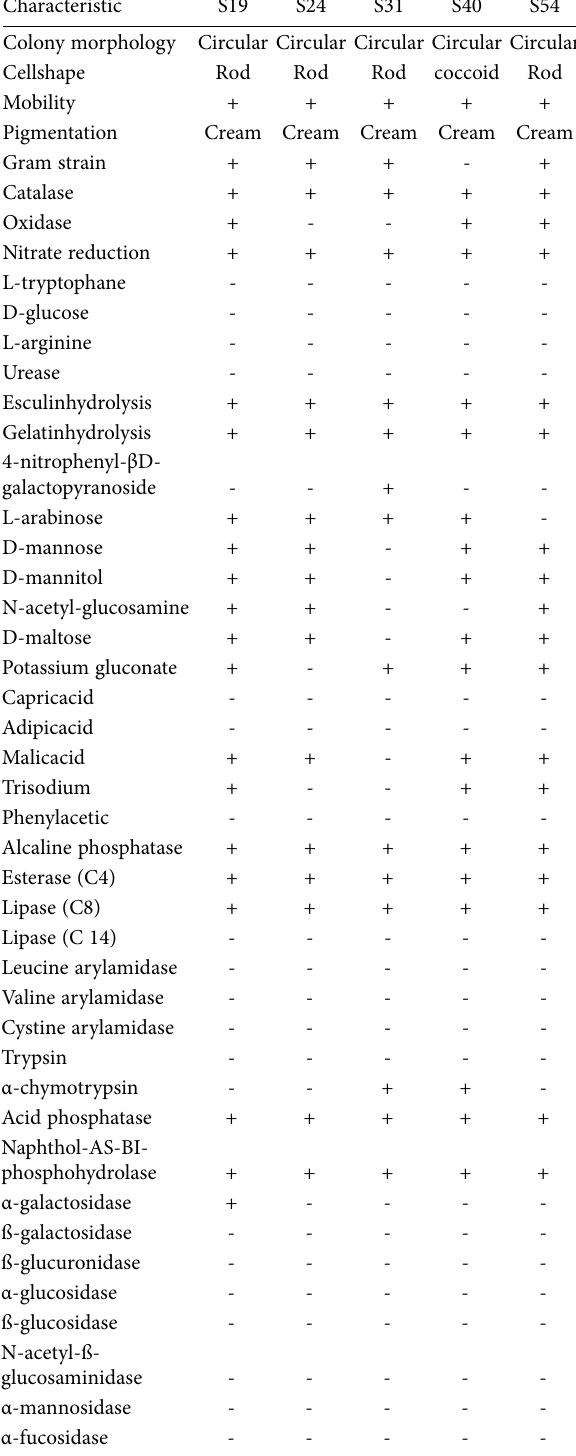
Table 1. Phenotypic characterization of selected antagonistic bacteria a .